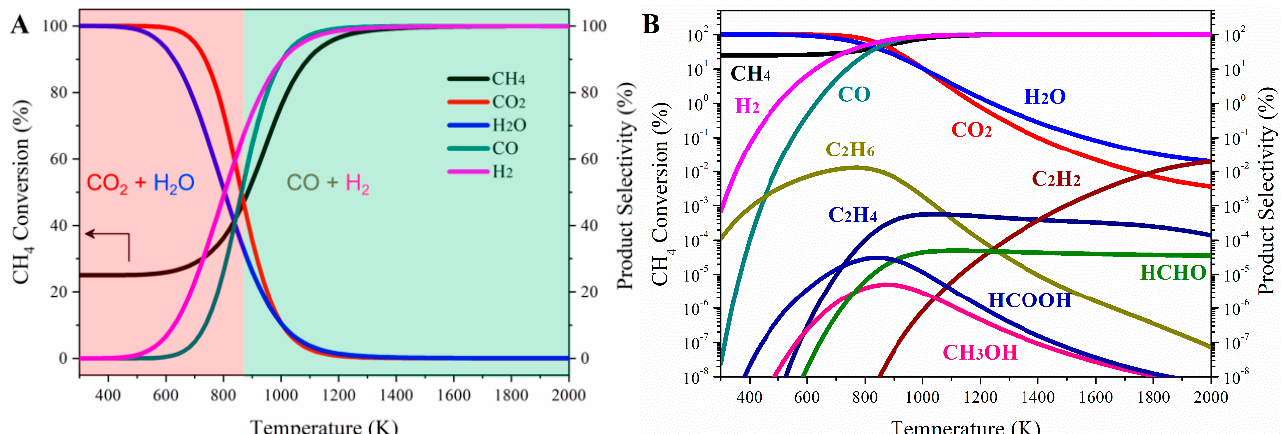
Figure 2. ( A ) Thermodynamic equilibrium of CH 4 conversion upon oxidation by O 2 (left axis), and product selectivity (right axis), as a function of reaction temperature at atmospheric pressure (mole ratio: CH 4 /O 2 = 2/1). ( B ) Product selectivity in logarithmic scale, illustrating the products with lower thermodynamic equilibrium selectivity, including CH 3 OH.